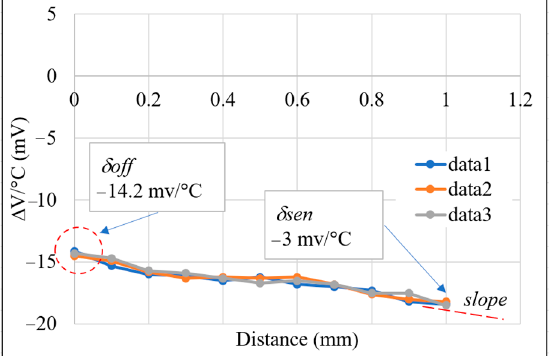
Figure 12. Correlation between temperature drift and sensing distance with no temperature com- pensation.